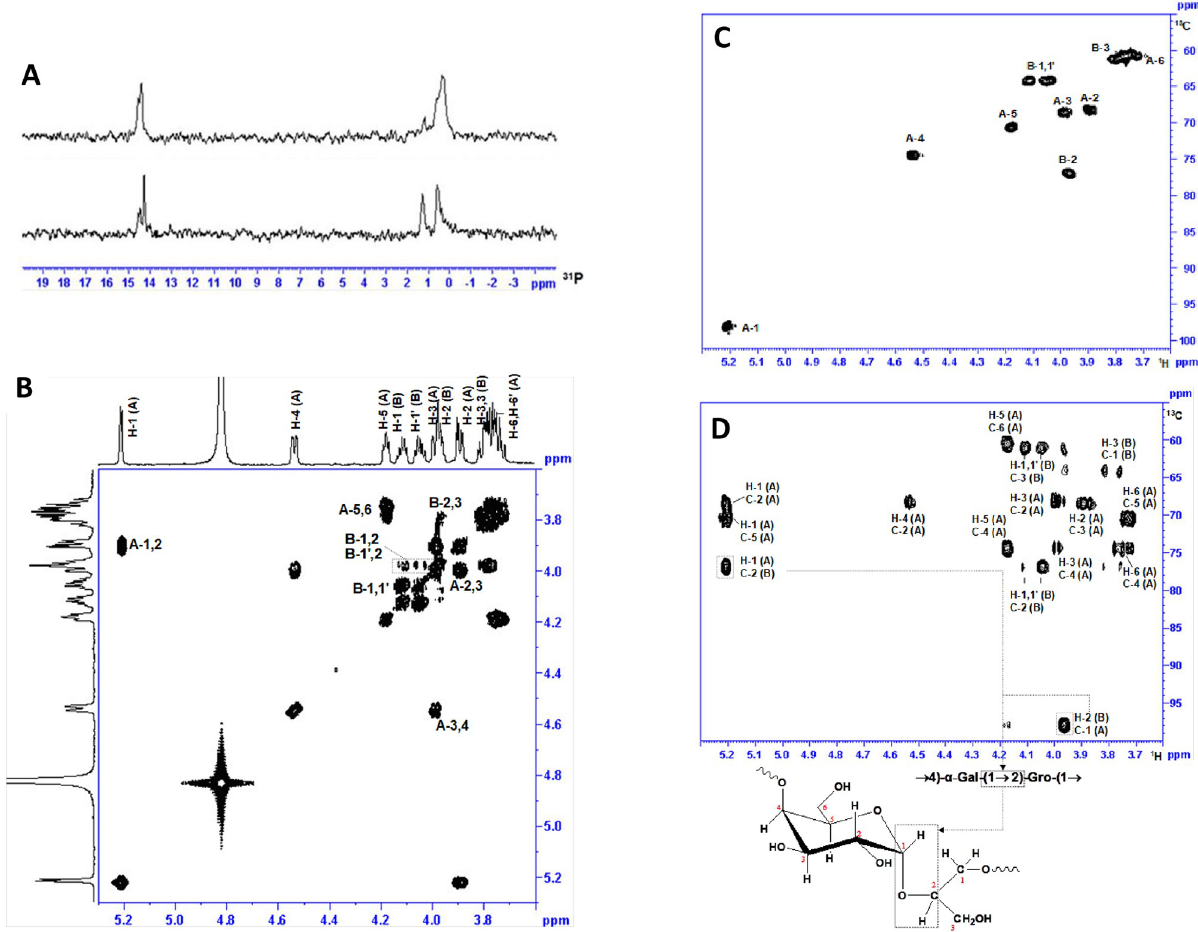
Fig 3. NMR of Penner HS1 type strain native CPS and HS1/44 native CPS and defructosylated CPS. (A) 1D 31 P NMR spectra of C . jejuni Penner HS1 type strain CPS (top) and HS1/44 CPS (bottom) showing the teichoic-acid phosphate resonances (0.02–1.25 ppm) and the MeOPN-3-Fru resonances (14.25–14.85 ppm); (B) 2D 1 H- 1 H COSY spectrum of defructosylated HS1/44 CPS; (C) 2D 1 H- 13 C HSQC spectrum of defructosylated HS1/ 44 CPS; (D) 2D 1 H- 13 C HMBC spectrum of defructosylated HS1/44 CPS.